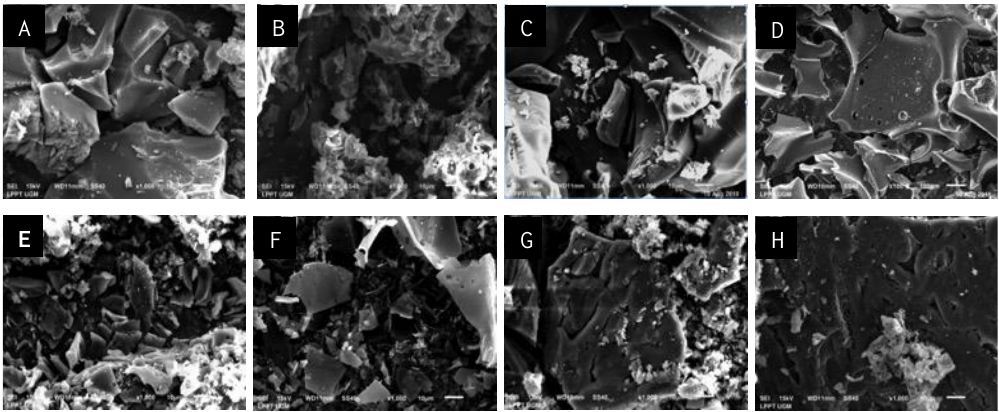
Figure 4. SEM images of carbon fibers: ( a ) LMPT-600; ( b ) LMPT-850; ( c ) LMP-600; ( d ) LMP-850; ( e ) LCC-600; ( f ) LCC-850; ( g ) LCS-600; ( h ) LCS-850. Figure ( c ) and ( d ) taken from our previous study [18],